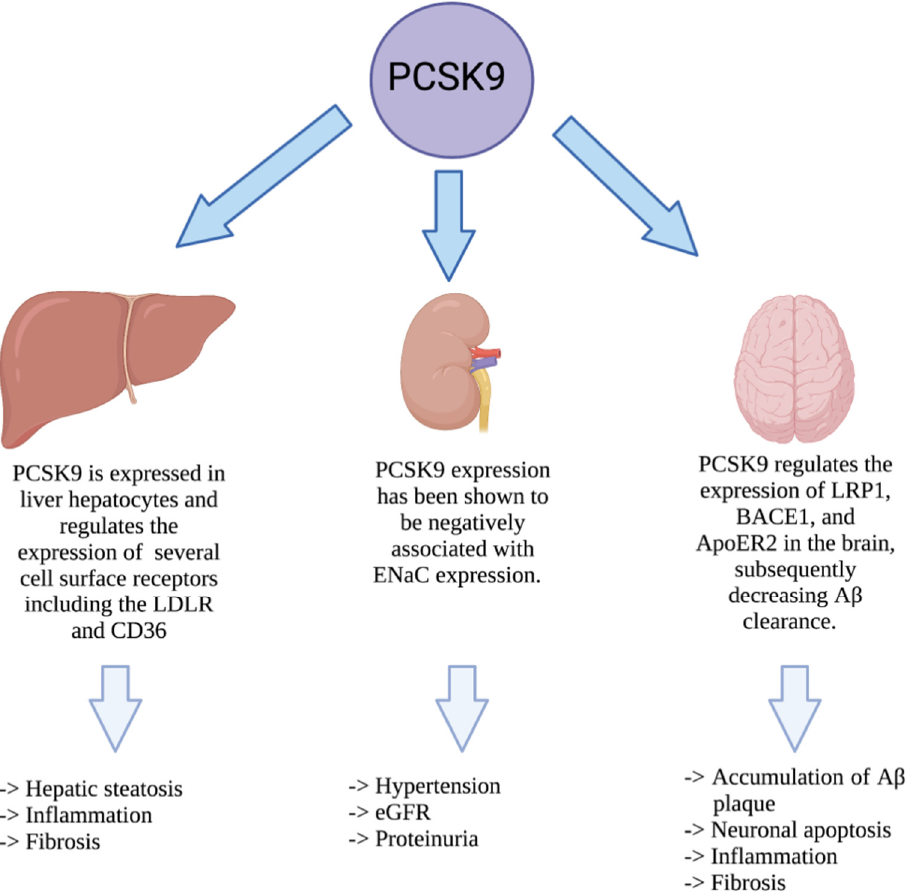
Figure 3. Impact of PCSK9 in non-cardiovascular diseases. PCSK9 is expressed in liver hepatocytes where it increases the stability of ER chaperones to protect against hepatic ER stress. Once secreted, PCSK9 can also contribute to hepatic steatosis, inflammation, and fibrosis. In the kidney, PCSK9 has been shown to affect hypertension, eGFR, and proteinuria. In the central nervous system, PCSK9 is also known to impact the accumulation of A β , leading to neuronal apoptosis, inflammation, and fibrosis.